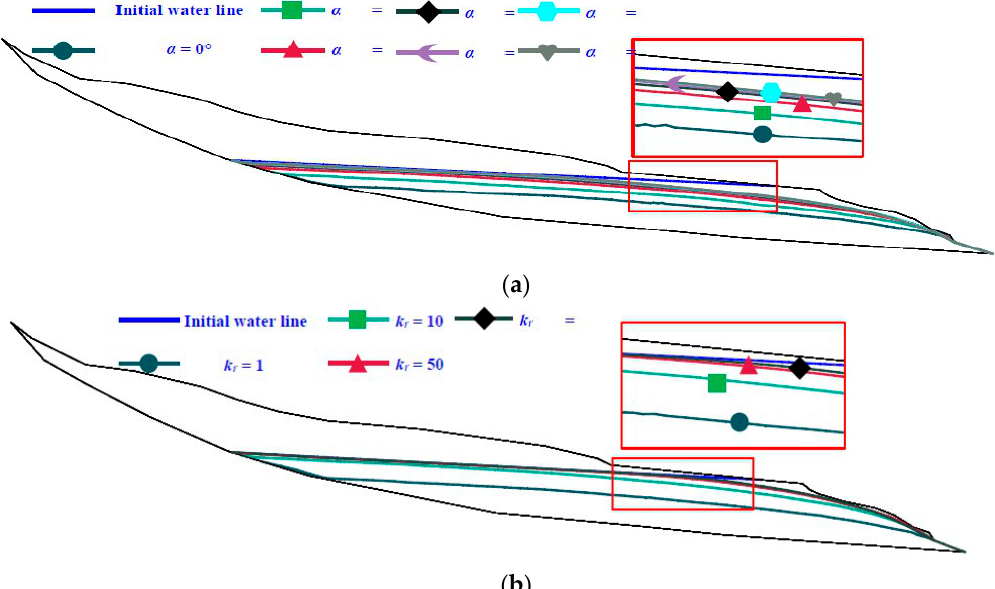
Figure 5. Effect of k r and α of sandy slope on the variations of infiltration lines. ( a ) Different α values with k r = 10. ( b ) Different k r values with α = 45°.